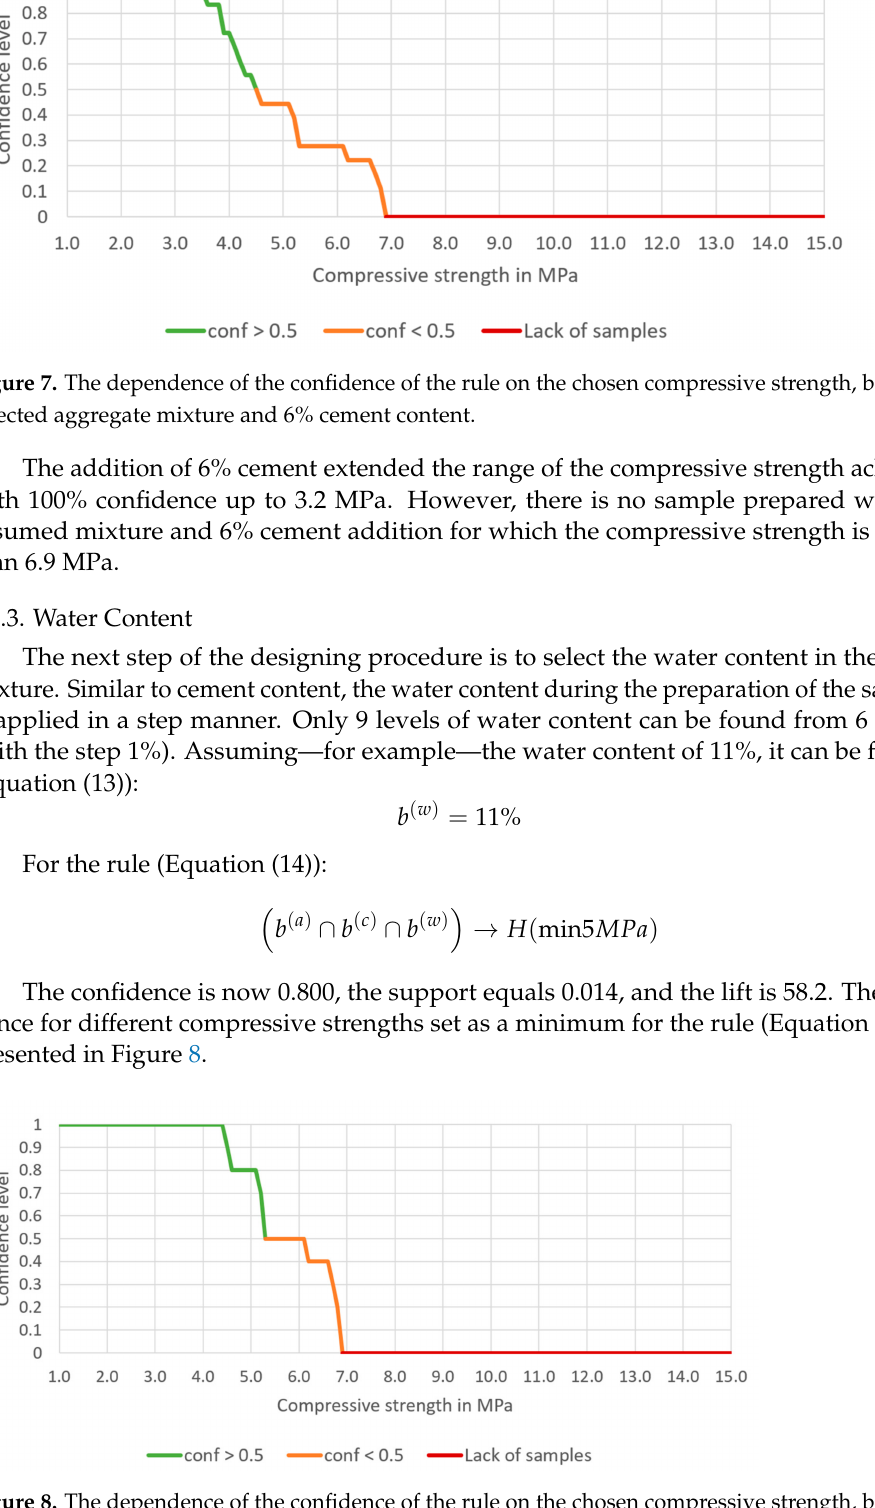
Figure 8. The dependence of the confidence of the rule on the chosen compressive strength, based on selected aggregate mixture and 6% cement content, and 11% water